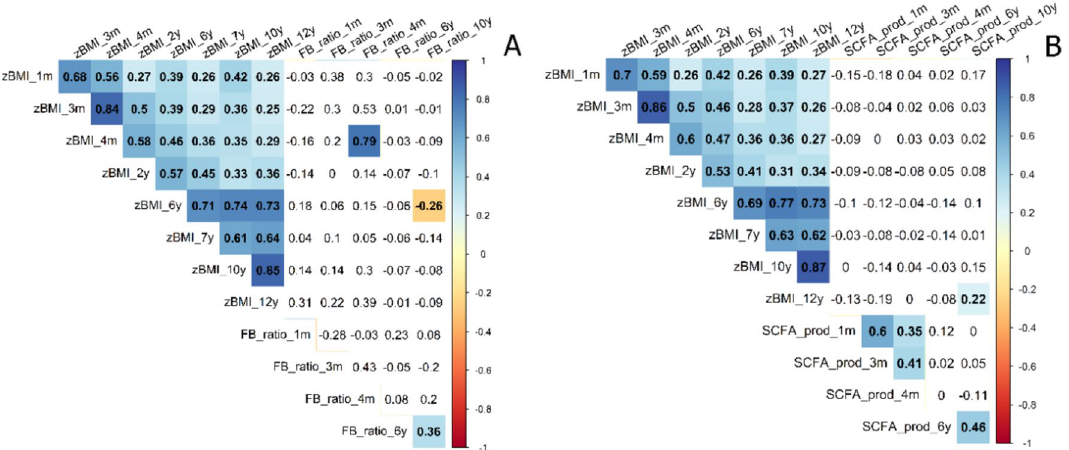
Figure 3. Spearman correlation matrices of main predictor and outcome varables. ( A ) Correlation Matrix between zBMI and F/B ratio over the ages. ( B ) Correlation matrix between zBMI and SCFA producers over the ages. Colored squares indicate significant values ( p <